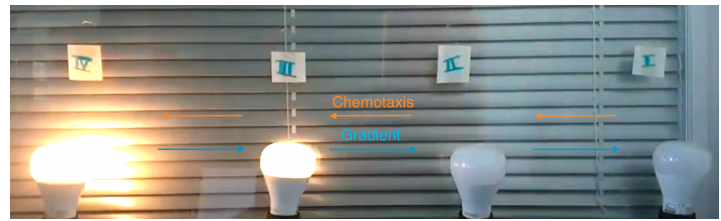
Figure 14. Smart lighting scenario.